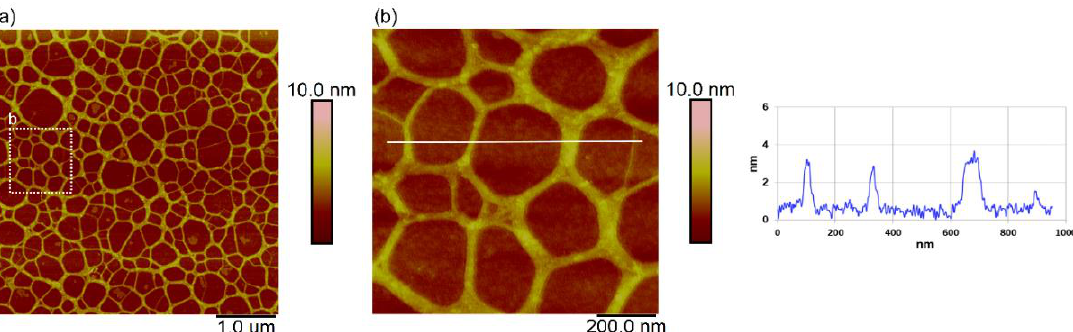
Figure 2. AFM images of extracellular polymers (EPS) isolated from Cylindrotheca closterium culture (200 µg mL −1 , suspension prepared in filtered natural seawater) showing a fibrillar network. Images were acquired using tapping mode in air and presented as height data with scan sizes 5 µm × 5 µm ( a ); and 1 µm × 1 µm ( b ). A vertical profile along the indicated line shows fibril heights.